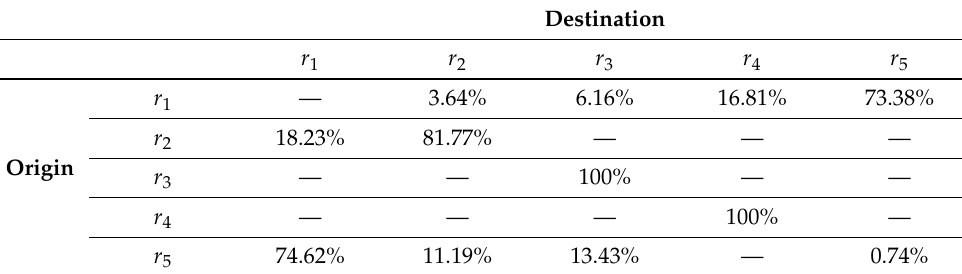
Table 4. Average directional movement